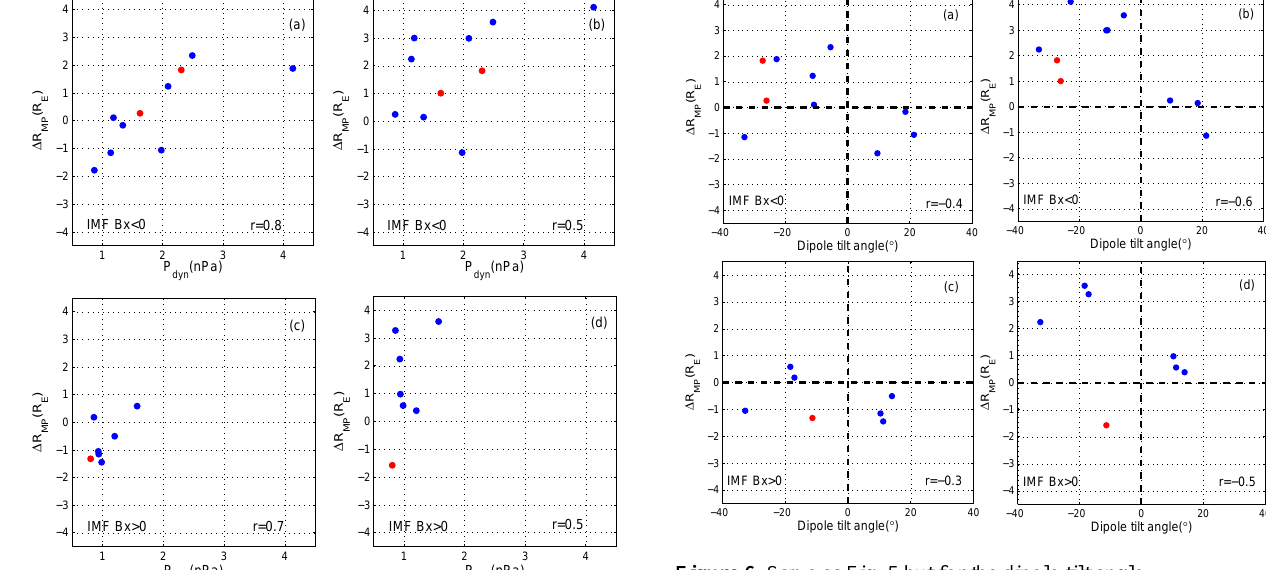
Figure 6. Same as Fig. 5 but for the dipole tilt angle. for both earthward and sunward RIMF events. The magne- topause expands further outward relative to the model predic- tion when the dipole tilt angle is more negative (local summer in the Southern Hemisphere). Note that the dipole tilt angle is not included in the Shue98 model, while it is included in the Boardsen00 model. The latter fact indicates that the dipole tilt effect is not fully represented by the Boardsen00 model. Previous work has shown that the dipole tilt angle has few ef- fects on the equatorial magnetopause but has great effects on the high-latitude magnetopause (Lin et al., 2010; Liu et al., 2012; Boardsen et al., 2000). As the dipole tilt angle becomes more negative, the high-latitude magnetopause is displaced inwards in the Northern Hemisphere, while in the Southern Hemisphere the magnetopause is displaced outward